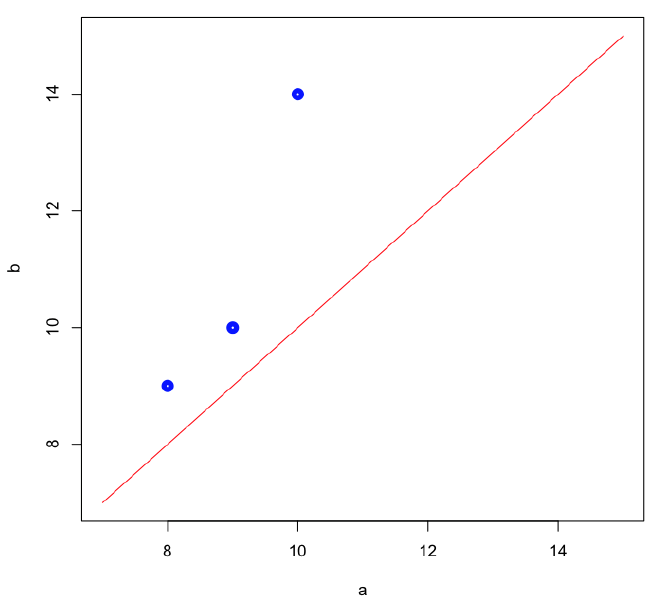
Figure 8. Persistence diagram for the map f X when X = ( 11,14,9,7,9,7,8,10,9 )